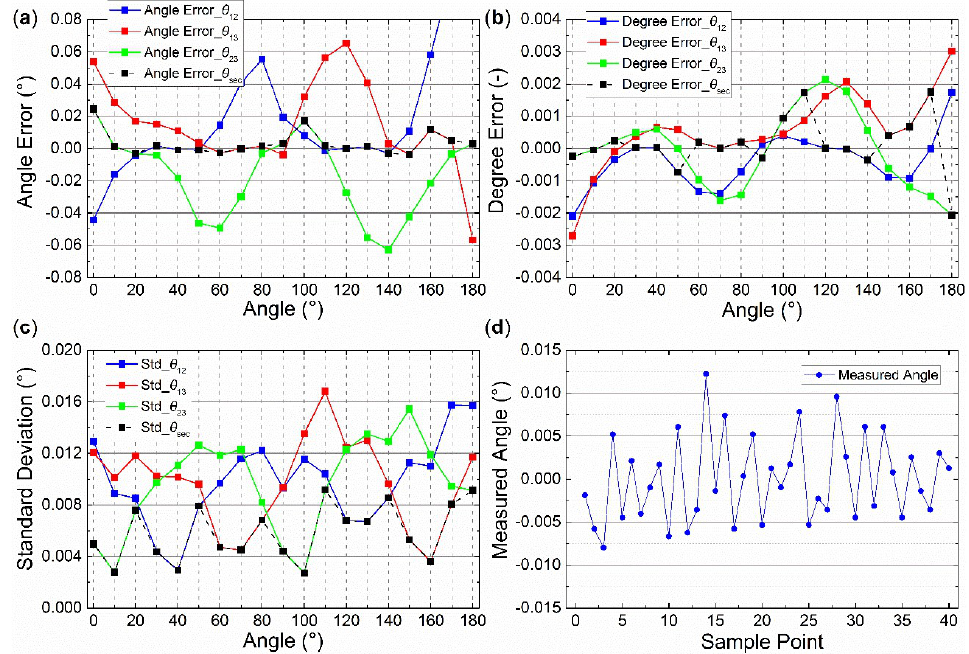
Figure 23. Outdoor2 errors after calibration at 16:43:08. ( a ) Angle error; ( b ) degree error; ( c ) standard deviation; ( d ) the 40 measured samples.